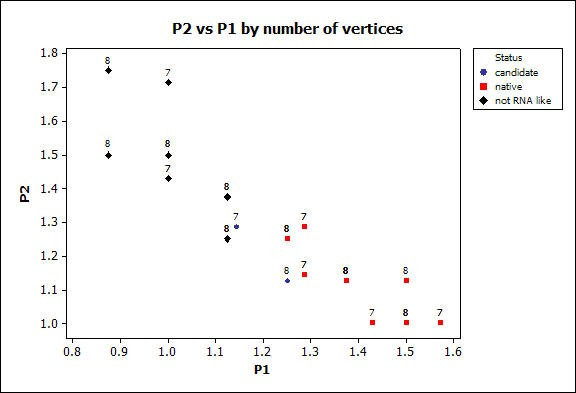
Scatter Plot for P1 vs P2.